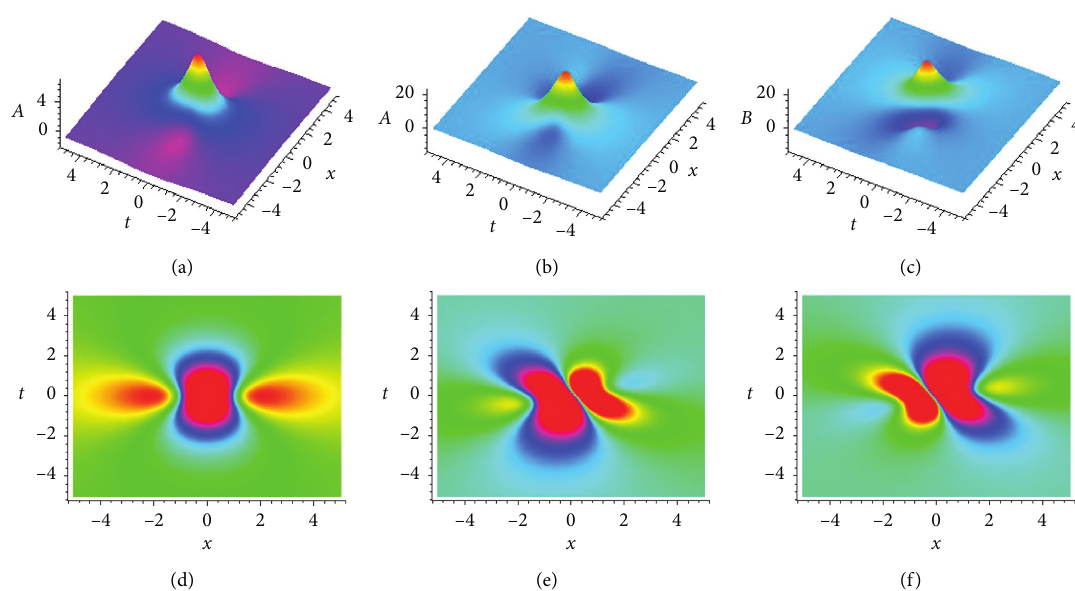
Figure 9: The one-order symmetry-breaking lump solutions (41a) and (41b) with (a) b corresponding density plots of (a)–(c), respectively.